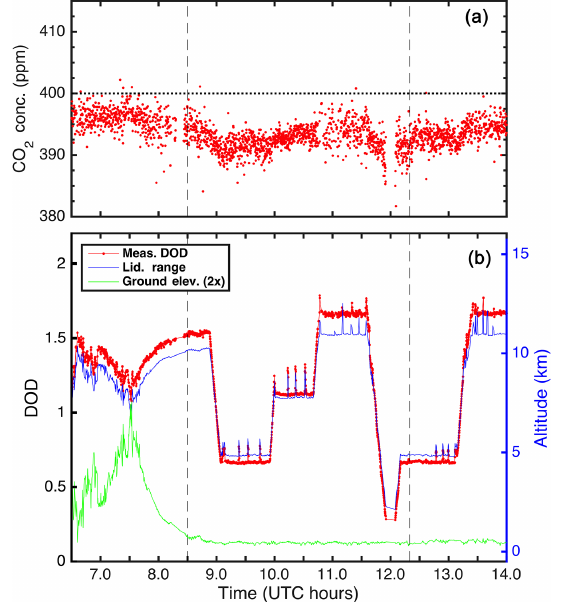
Figure 20. Lidar measurement and retrieval results from 2014 SF5 flight over Iowa on 3 September 2014. This flew a square flight pat- tern near the NOAA West Branch, Iowa, tower at three different alti- tudes. (a) The retrieved XCO 2 values from the lidar measurements, with each dot made using 10s averaging time. (b) Time-resolved results showing the lidar-measured differential optical depth, the range to the surface and the computed surface elevation. The lidar- measured range to the scattering surface and the scattering surface “ground” elevation are plotted against the right-hand axis. The up- ward spikes in the DOD and range are from the slant paths during the banking of the aircraft during the corners of the box pattern. The measurements between the dashed lines are summarized in Fig.